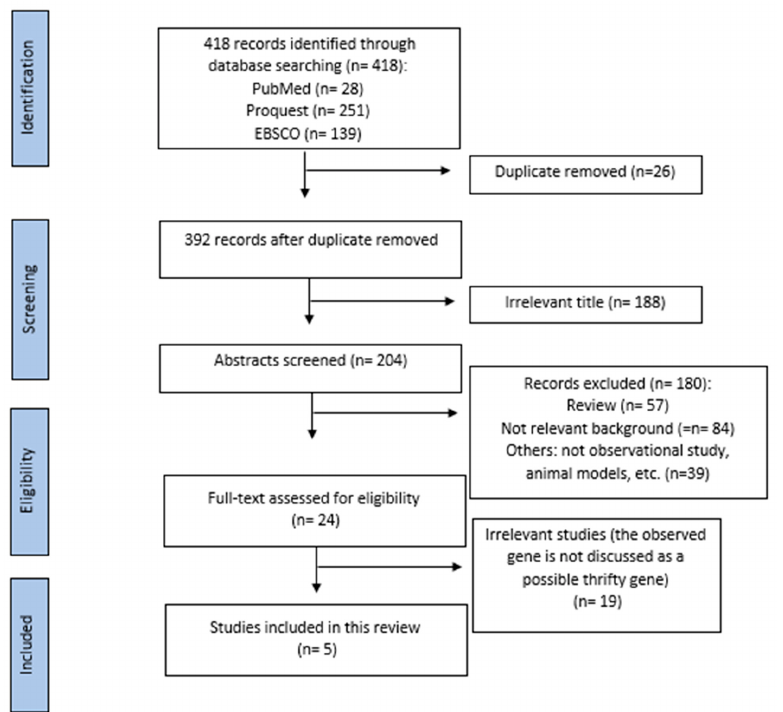
Figure 1. PRISMA diagram of the articles included.